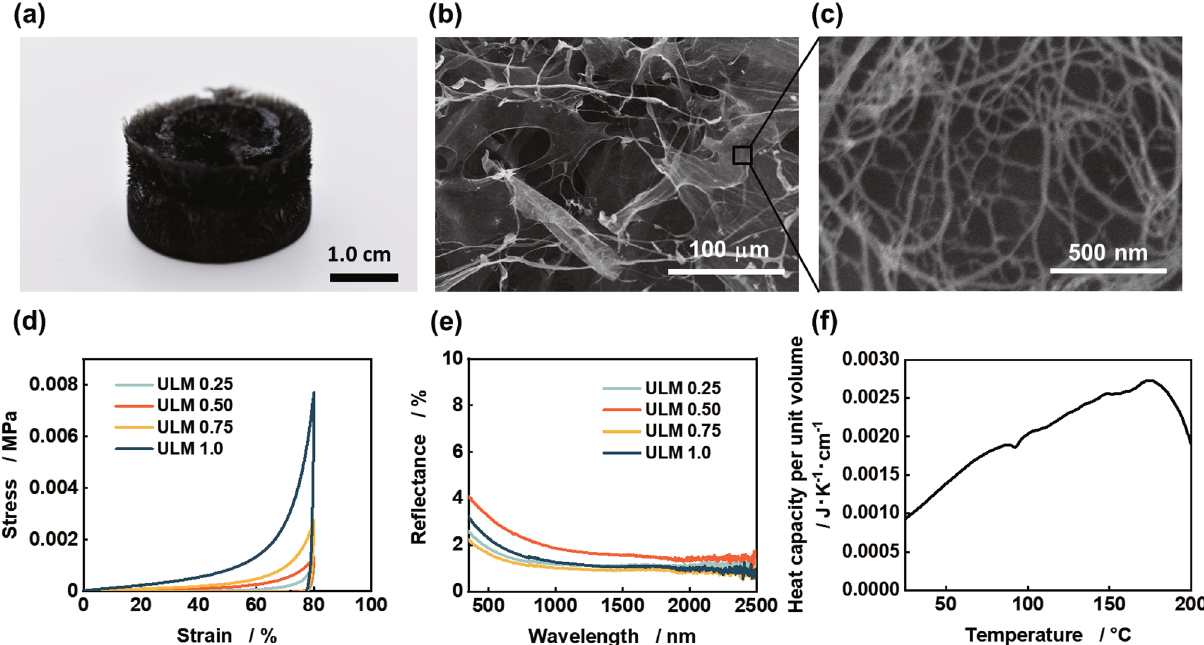
Figure 2. Material characterization of the ultralight aerogels. ( a ) Optical image of the aerogel. ( b ) SEM image at low magnification (×400). ( c ) SEM image at high magnification (×80,000). The optical and SEM images are of ULM 0.75. ( d ) Stress–strain curves of the ultralight aerogels fabricated by varying the prepared density. ( e ) Diffusive reflectance spectra of the ultralight aerogels fabricated by varying the prepared density. ( f ) Heat capacity per unit volume of ULM